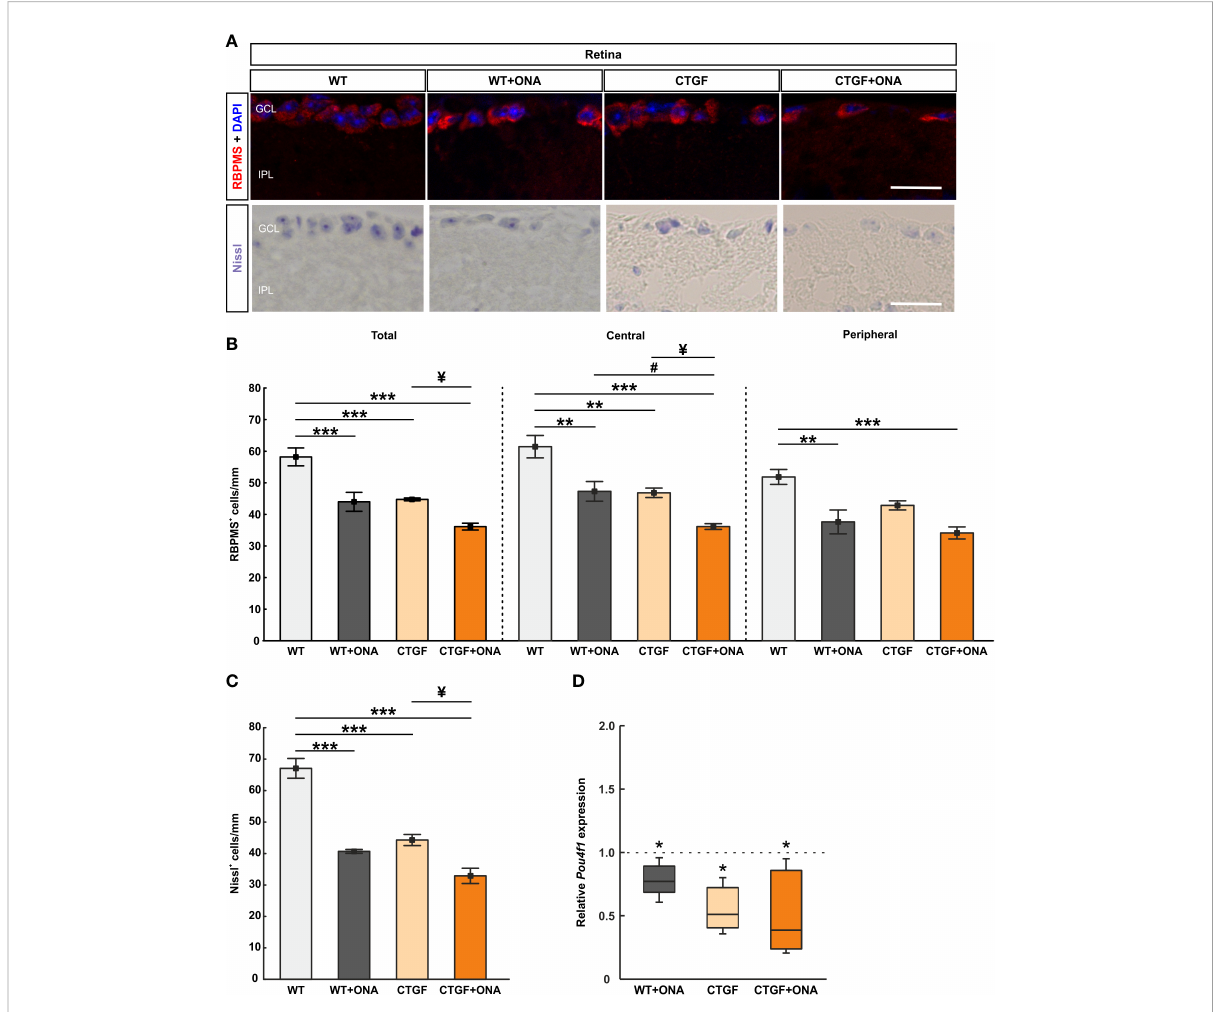
FIGURE 7 Additive loss of retinal ganglion cells in CTGF+ONA retinae. (A) Retinal cross-sections were stained with Nissl to label neurons. Further, an antibody against anti-RBPMS (red) labeled RGCs. DAPI was used to counterstain cell nuclei (blue). (B) The total number of RGCs was signi fi cantly decreased in WT+ONA, CTGF, and CTGF+ONA retinae compared to WT. Further, RGC counts were signi fi cantly lower in CTGF +ONA mice in comparison to CTGF mice. In the central part of the retina, the number of RGCs was diminished in WT+ONA, CTGF, and CTGF +ONA animals compared to WT. In addition, fewer RGCs were counted in CTGF+ONA retinae compared to WT+ONA and CTGF mice. In the peripheral area of the retina, RGCs numbers were lower in WT+ONA and CTGF+ONA mice. (C) The number of neurons in the GCL was signi fi cantly decreased in WT+ONA, CTGF, and CTGF+ONA retinae compared to WT. While no alterations were noted when comparing WT +ONA to CTGF+ONA mice, signi fi cantly lower numbers of neurons were observed in CTGF+ONA animals compared to CTGF ones. (D) The mRNA expression levels of Pou4f1 were signi fi cantly downregulated in WT+ONA, CTGF, and CTGF+ONA mice. GCL=ganglion cell layer; IPL=inner plexiform layer. Values are median ± interquartile range ± range for immunohistology and median ± quartile ± minimum/maximum for RT-qPCR. The dotted line in (D) represents the relative expression of the WT group. *p<0.05, **p<0.01, and ***p<0.001 vs . WT; # p<0.05 vs . WT+ONA; ¥ p<0.05 vs . CTGF. Scale bars: 20